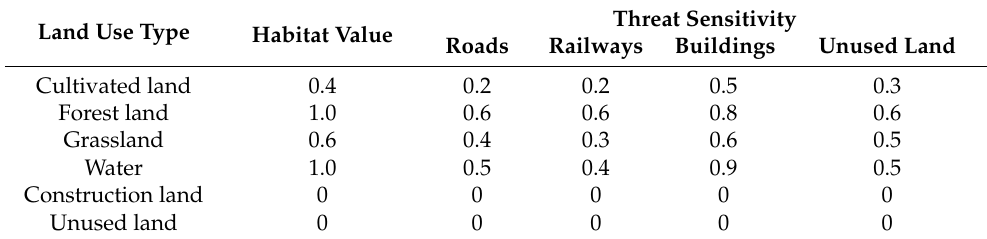
Table 3. Habitat value and threat sensitivity of different land use types.